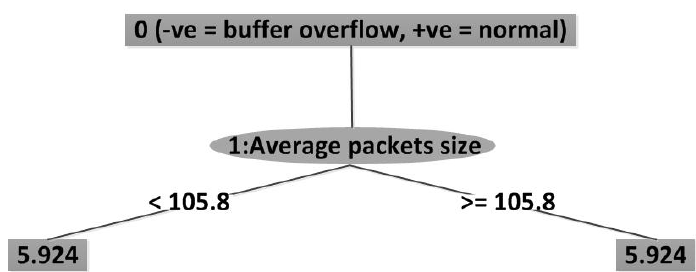
Figure 10. A result of